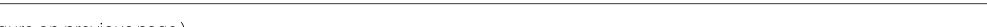
(See figure on previous page.) Fig. 4 Geotail particle and field observations during thinning and expansion of the plasma sheet ( upper panels ) and GOES 14–15 and the MMS magnetic field observations during the dipolarization events ( lower panels ). a Total pressure ( black ) and magnetic pressure ( brown ), b X , Y , and Z components of the magnetic fields, c ion flows perpendicular to the magnetic field, and d parallel current determined from ion and electron moment data and energy spectra of ions streaming sunward ( e ), duskward ( f ), tailward ( g ), and dawnward ( h ) as observed by Geotail between 09:50 and 10:30 UT. The dashed lines in a – h show the beginnings of the disturbances associated with the exit and reentry of the plasma sheet. i Absolute value of the V , j D and k H components of the magnetic field from MMS 3 ( black ) GOES 15 ( red ) and GOES 14 ( blue ) between 09:56 and 10:06 UT. The dashed lines in i – k show the start of the rapid dipolarization fronts for each spacecraft. The horizontal bars highlight the disturbances in the D components associated with dipolarization (discussed in greater detail in the